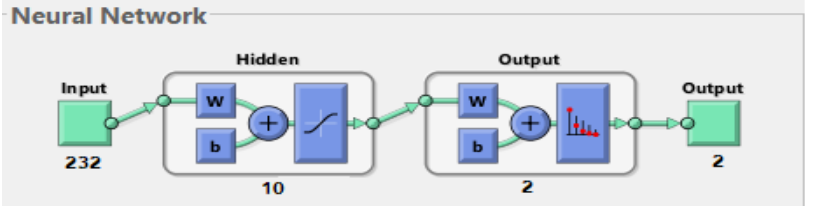
Figure 12. Training of the feed forward neural network classifier of the ALL_IDB1 and ALL_IDB2 datasets.